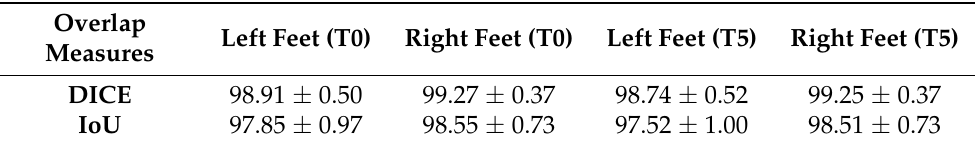
Table 1. Overlap measures between the segmented masks produced by each researcher for each foot, at each time point, T0 and